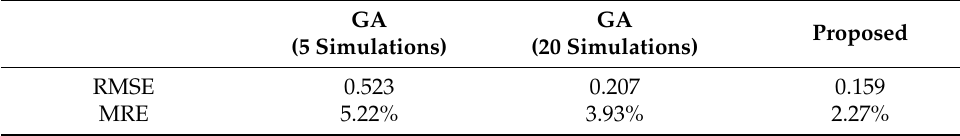
Table 1. RMSE and MRE of the inversion results.